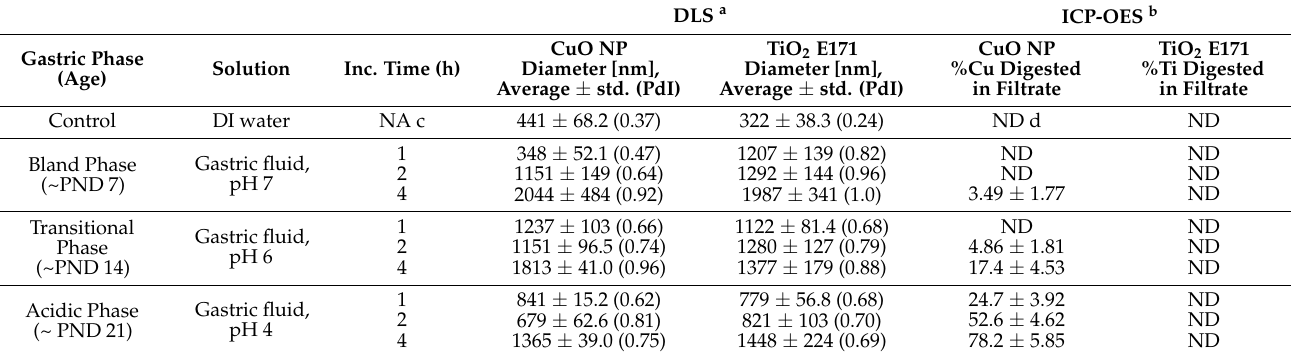
DLS a ICP-OES b